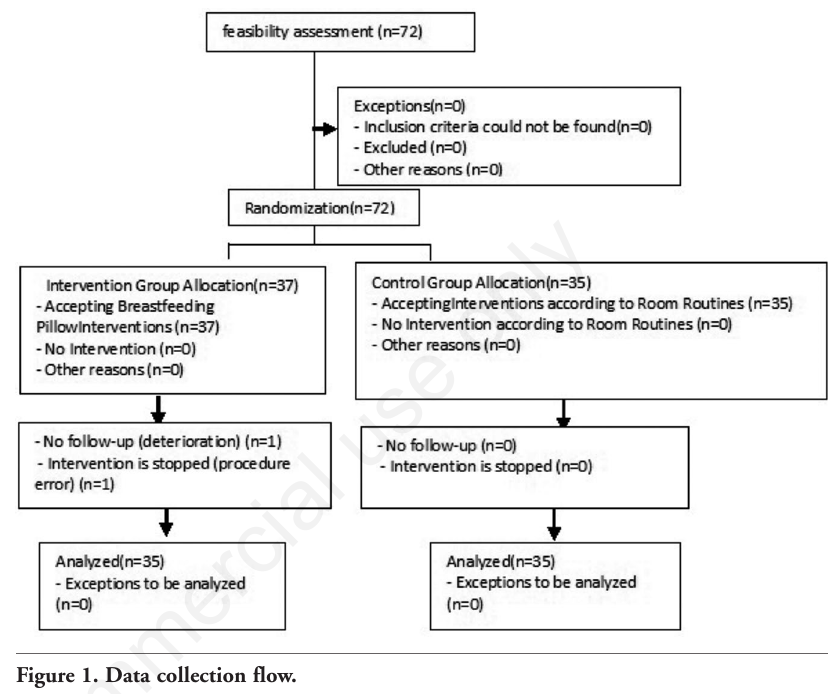
Figure 1. Data collection flow.